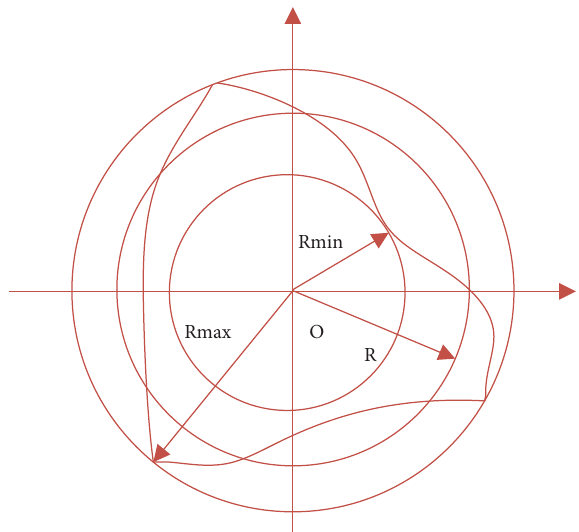
Figure 2: Standard least square circle method (LSCM).